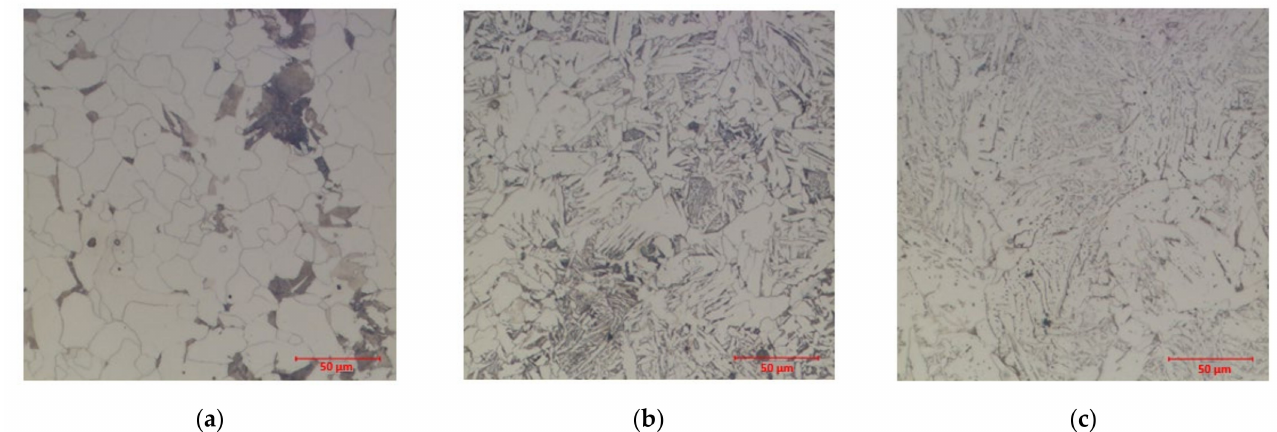
Figure 12. Microstructure of the as-welded specimen. ( a ) Parent material; ( b ) HAZ; and ( c ) weld metal.